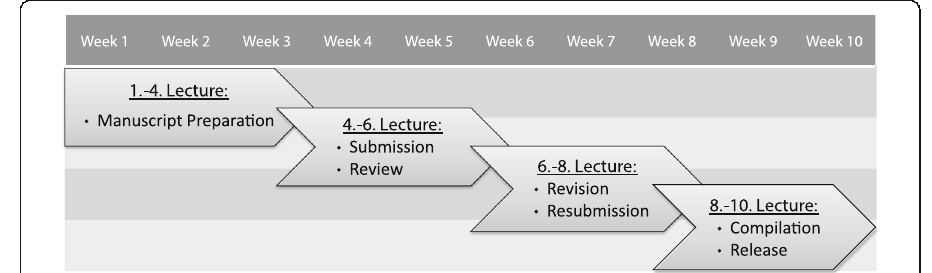
Fig. 1 Scheduling of the in-Class Peer Review procedure over 10 weeks for the experimental